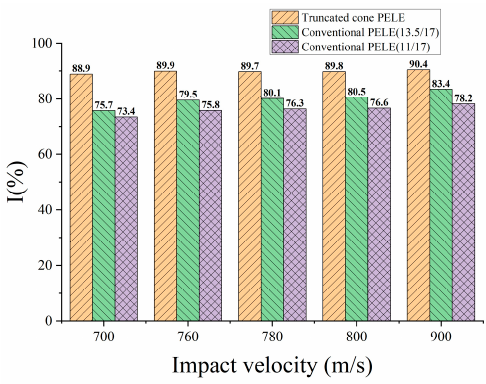
Figure 3. Comparison of PELE projectiles with different structures.